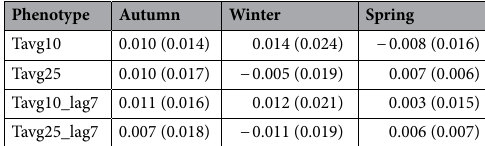
Table 2. Descriptive statistics (mean and SD in parentheses) of seasonal animal resilience phenotypes at different temperature levels. Tavg10, Tavg25: milk yield change by 1 °C temperature change at 10 °C and 25 °C on the milk test date, respectively; Tavg10_lag7, Tavg25_lag7: milk yield change by 1 °C cumulative average air temperature change during the week preceding the milk test date.